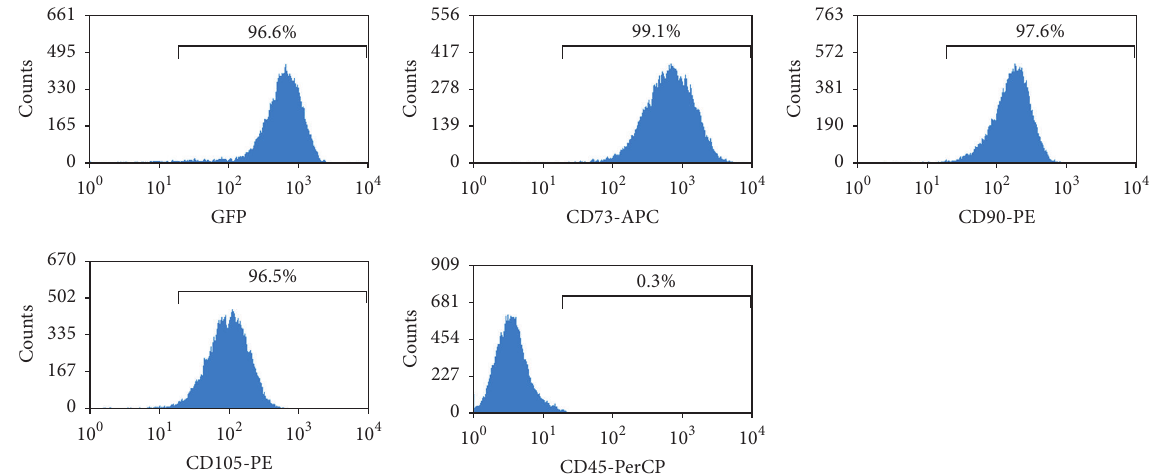
Figure 3: Immunocharacterization of hESC-OPs (GFP+) using flow cytometry for expression of surface